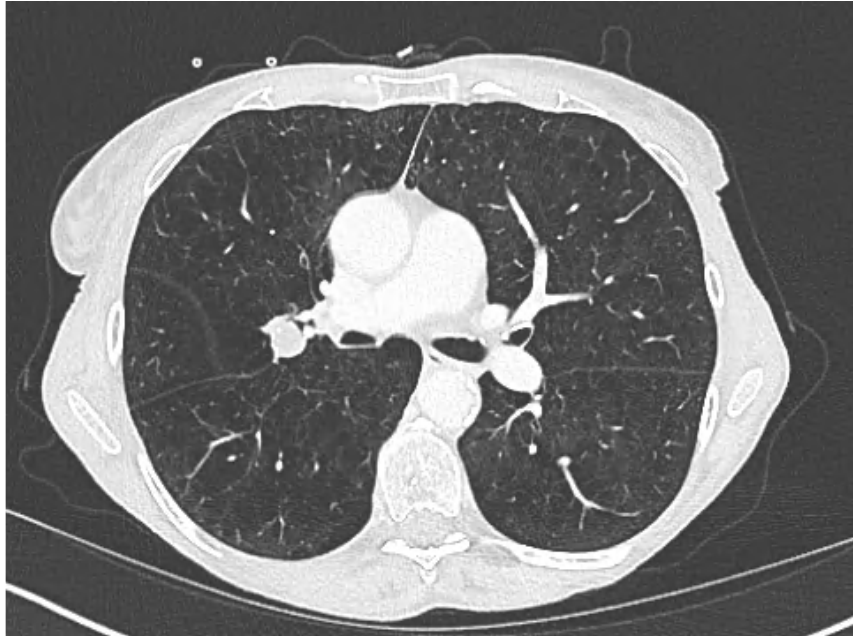
Figure 3. Computed tomography scan at 5 months of lung stereotactic radiotherapy.